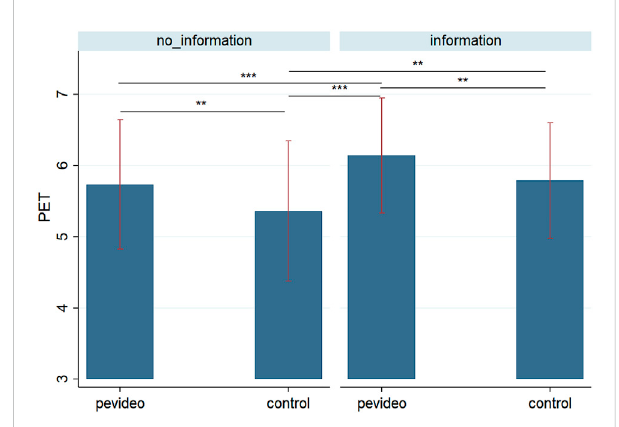
FIGURE 4 Participants ’ PET of two groups between two treatments. Note: ***p < 0.001, **p < 0.01.